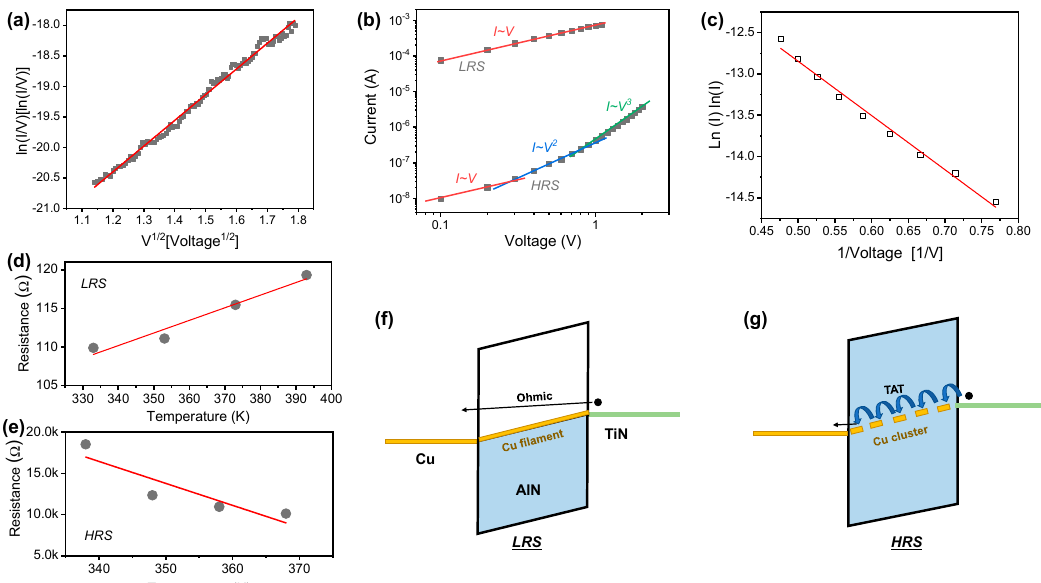
Figure 3. Conduction mechanism of Cu / AlN / TiN device. ( a ) ln( I / V ) versus V 1 / 2 for Poole-Frenkel emission; ( b ) Log-log fitting of non-volatile I – V curves for power law; ( c ) ln(I) versus 1 / V for TAT model; Temperature dependence in the ( d ) LRS and ( e ) HRS; ( f ) Ohmic and ( g ) TAT model in band diagrams in the LRS and HRS, respectively.